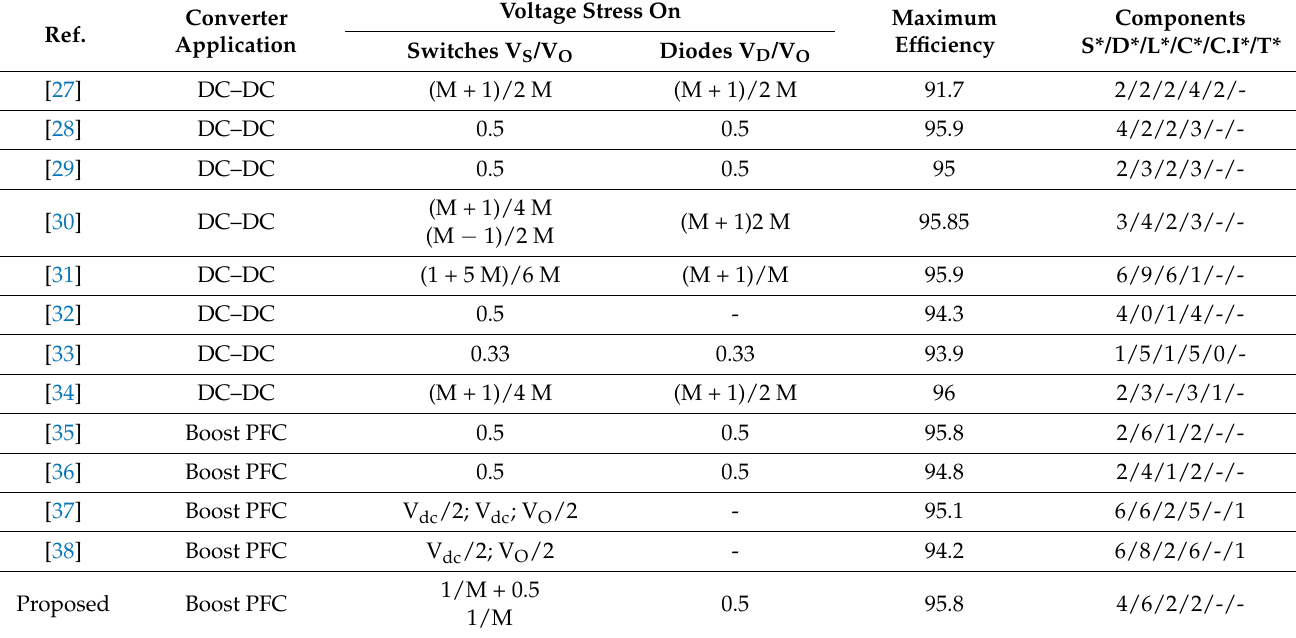
Table 1. Comparison of the proposed topology with similar